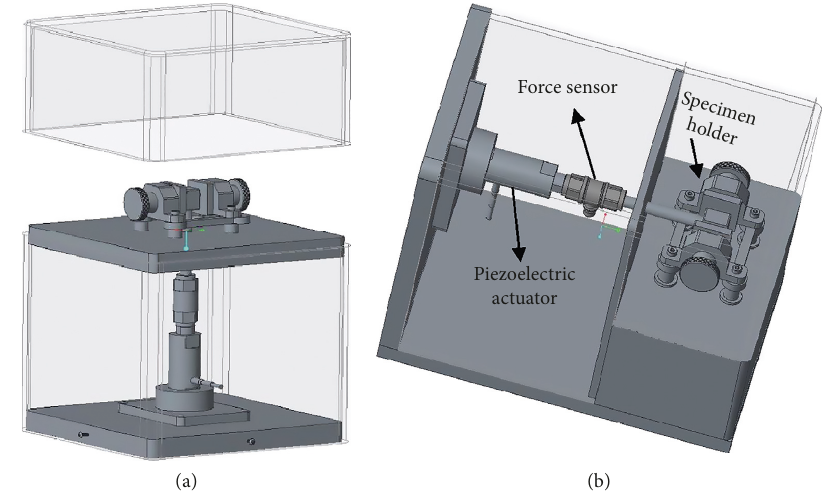
Figure 8: Clamp design: (a) vertical and (b)